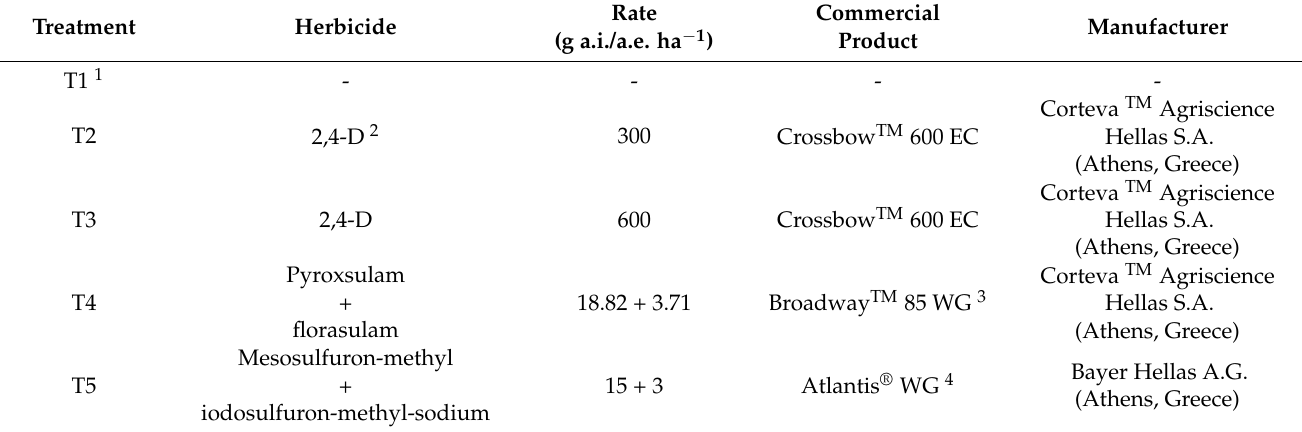
Table 2. Application rates, commercial products, and manufacturer names of herbicides included in the treatment list in all four